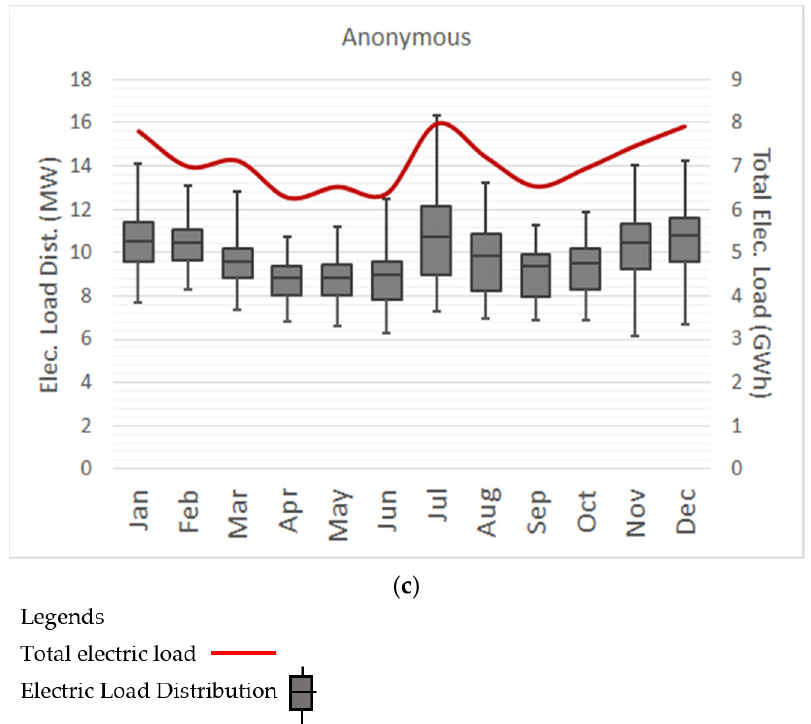
Figure 4. The three municipalities, ( a ) Negaunee, ( b ) L’Anse, ( c ) Anonymous, and their load profile with average monthly consumption.